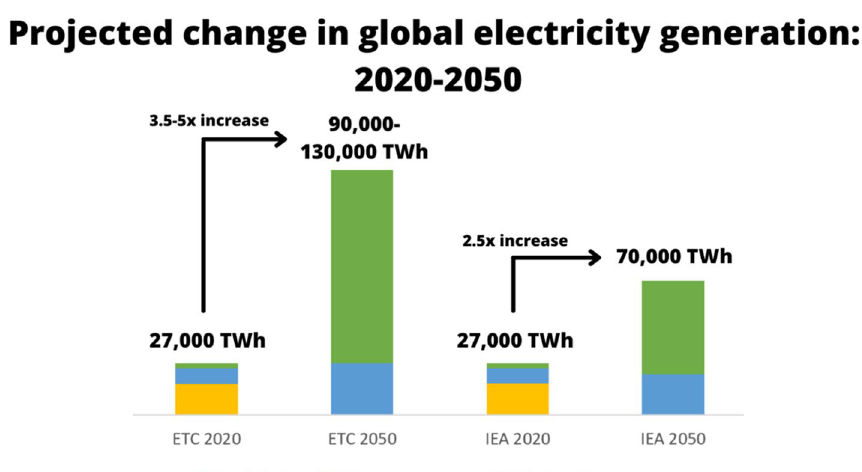
Fig. 3 Comparison of projected change in global electricity generation between 2020 and 2050 in both the ETC and IEA net zero emission scenarios. Author supplied